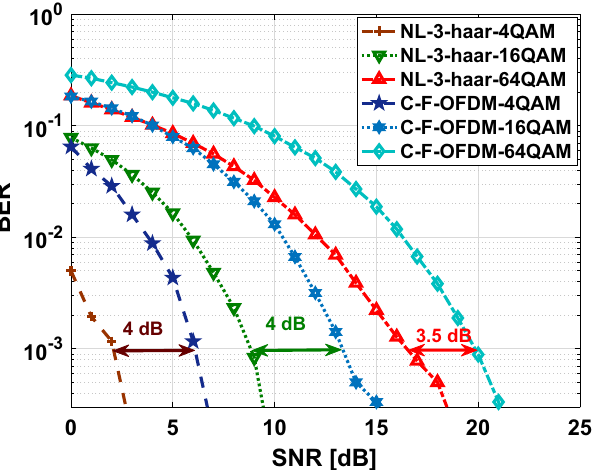
Figure 12. Comparison of BER of multilevel F-OWDM signal based on the “ haar ′′ transform technique.